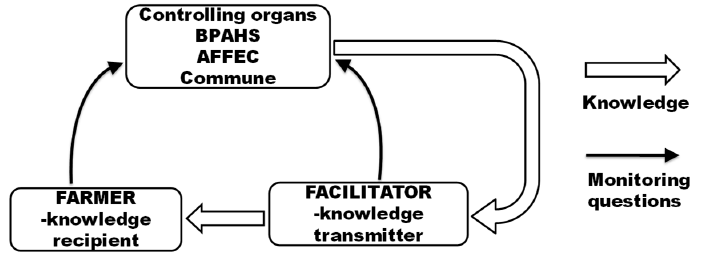
Figure 2. Indicators of assessment.